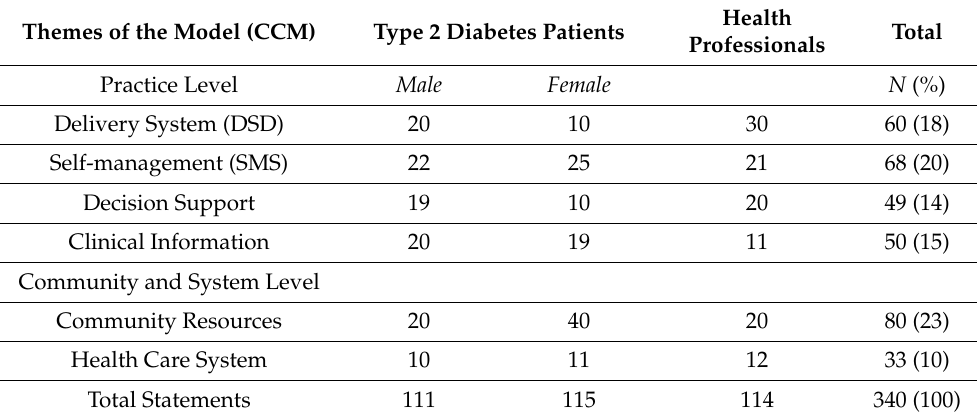
Table 1. Number of factors affecting the self-management of type 2 diabetes outcome. Themes of the Model